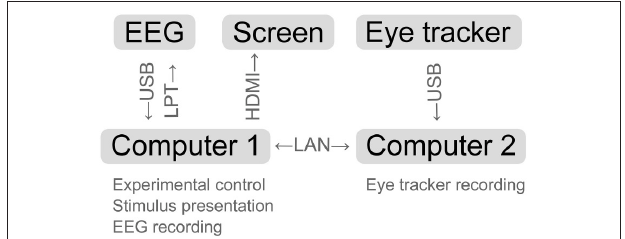
FIGURE 3 | Schematic representation of the experimental setup. Arrows indicate the data flow between the devices.